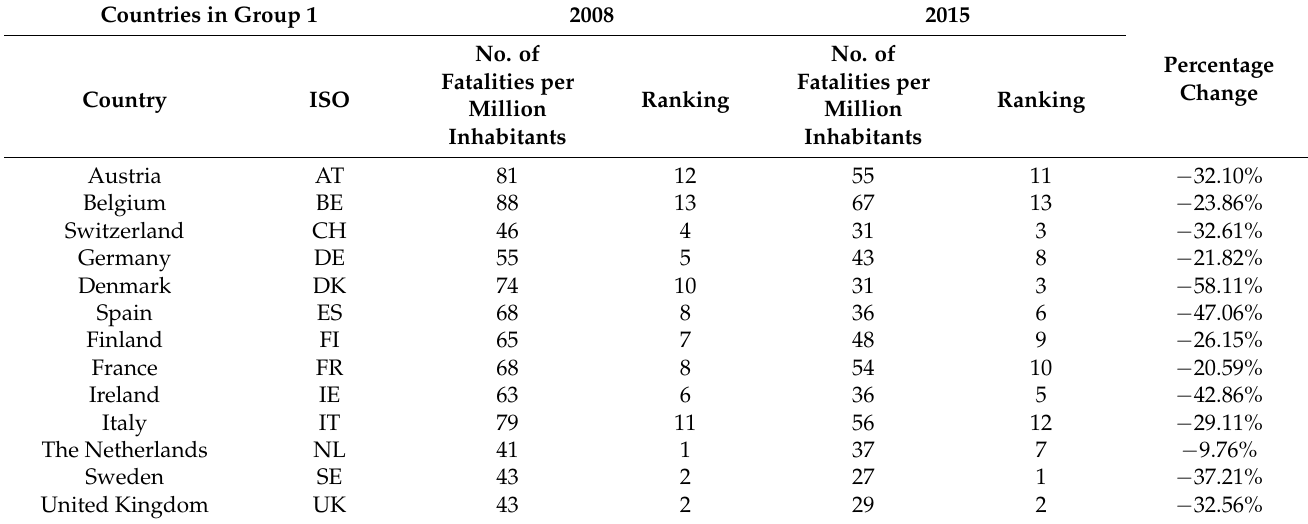
Table A3. The road fatality data for the countries in Group 1.